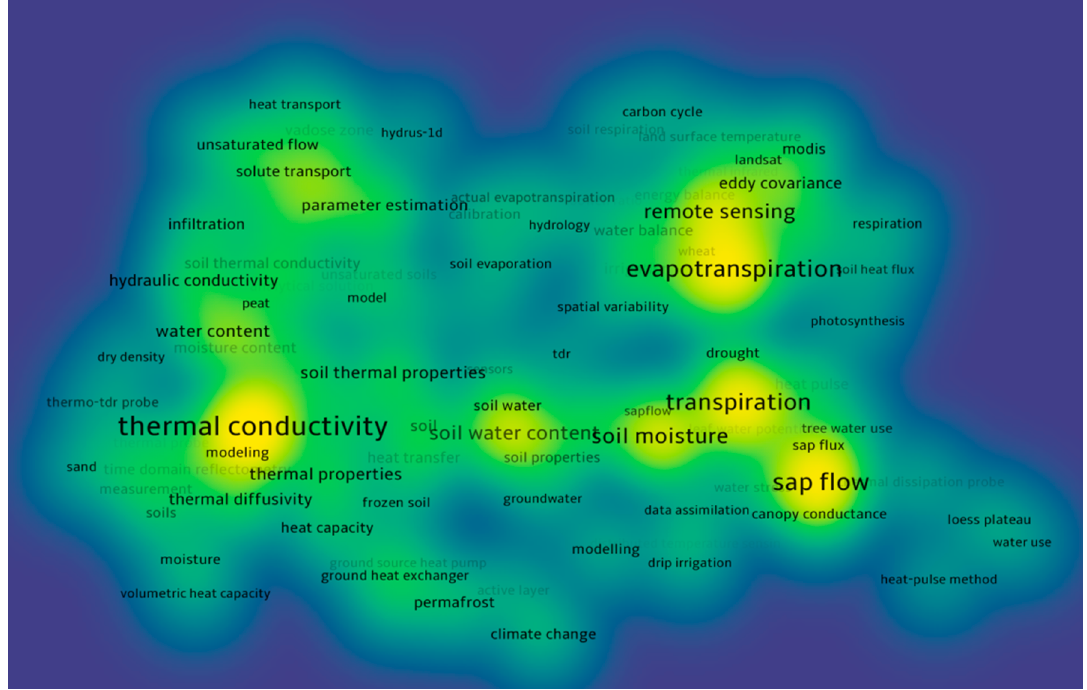
Figure 5. Density visualization of keywords co-occurrence in keyword list provided by the authors with one occurrence (produced with VOSviewer). Note: the number of co-occurrences of n keywords indicates the number of publications in which all n keywords occur together. Font size and density (background color) of keywords are used to represent the total link strength (TLS). Greater font size indicates greater TLS and a TLS of yellow > green > blue, while the distance between each keyword indicates the relatedness of these research topics.